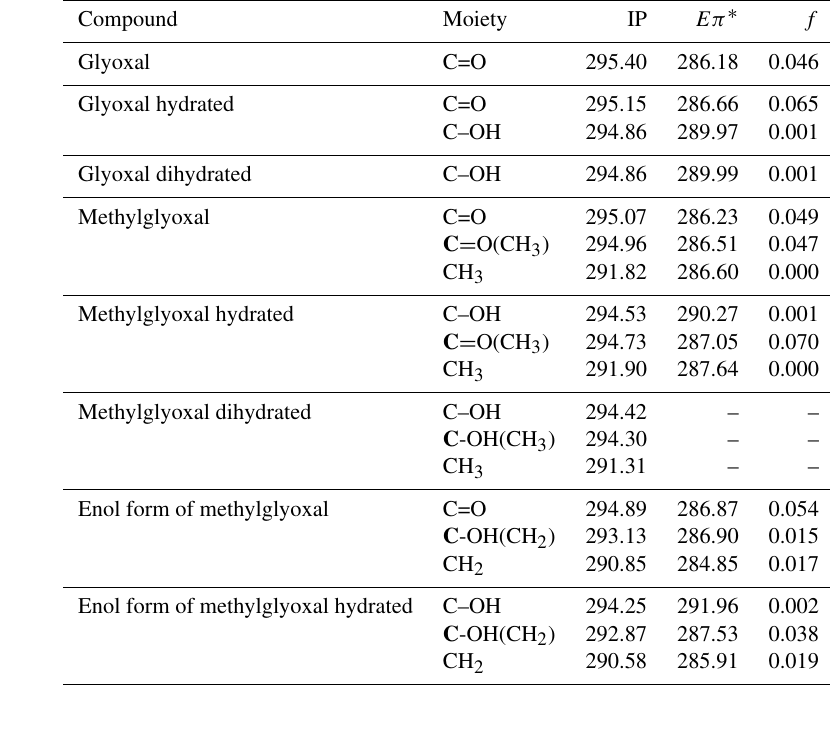
Table 3. Calculated C 1s ionization potentials (IPs) and C 1s- π ∗ bound-state excitation energies ( Eπ ∗ ) below IP in eV with oscillator strengths ( f ) of moieties present in hydrated forms of glyoxal and methylglyoxal, shown in Figs. 1 and 2. For moieties with more than one carbon atom, we denote with bold ( C ) the carbon atom that is related to the calculated value. For dihydrated methylglyoxal, our calculations did not identify any C 1s- π ∗ excitations in the energy range of the recorded spectra and only the calculated IPs are presented below.